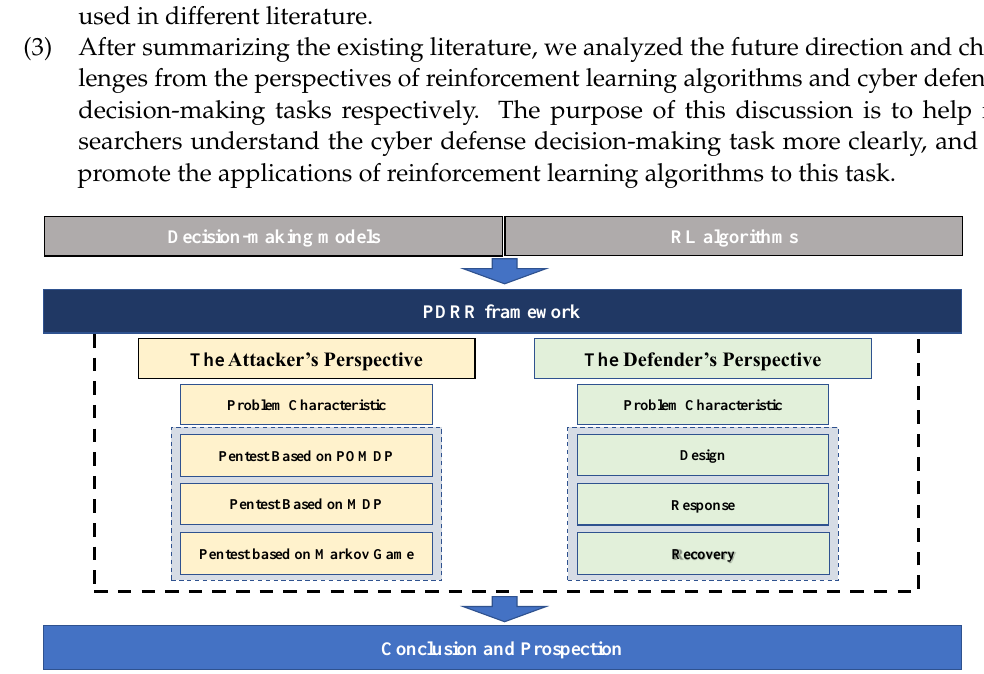
Figure 2. The structure of this